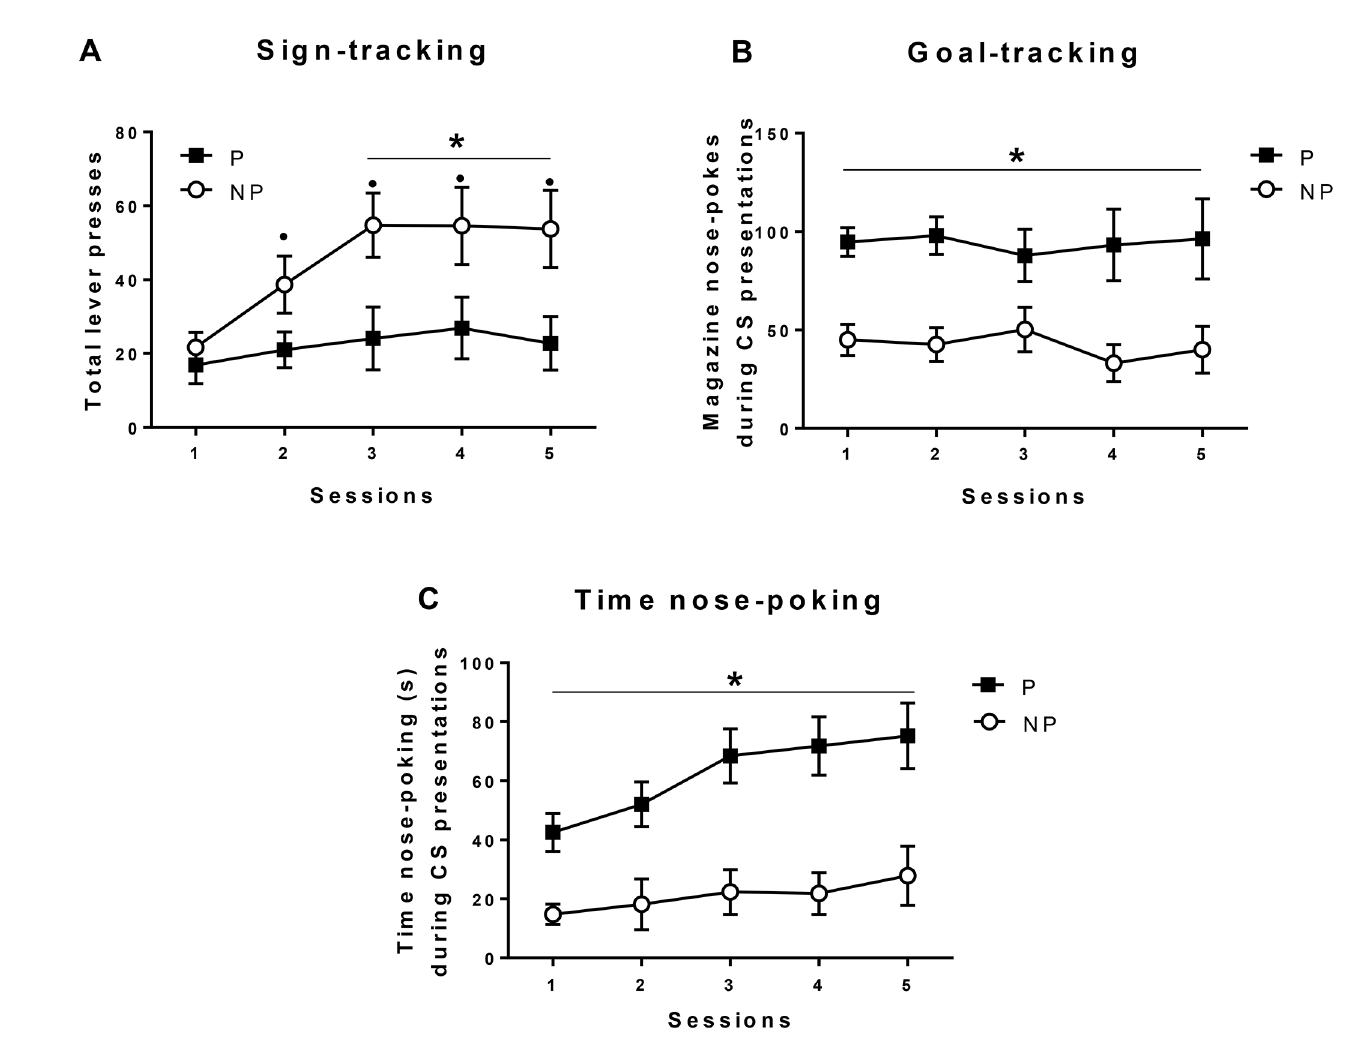
Fig 2. Pavlovian conditioned approach. Acquisition of Pavlovian conditioned approach in alcohol-preferring rats (P, closed squares) and alcohol-non- preferring rats (NP, open circles). Data are means ± SE of total lever presses (sign-tracking responses, a), total magazine nose-pokes during the CS-lever presentations (goal-tracking responses, b), and total time spent nose-poking during the CS-lever presentations (c). All p < 0.05: ( * ) significant group differences, ( (cid:129) ) versus session 1 in NP rats.